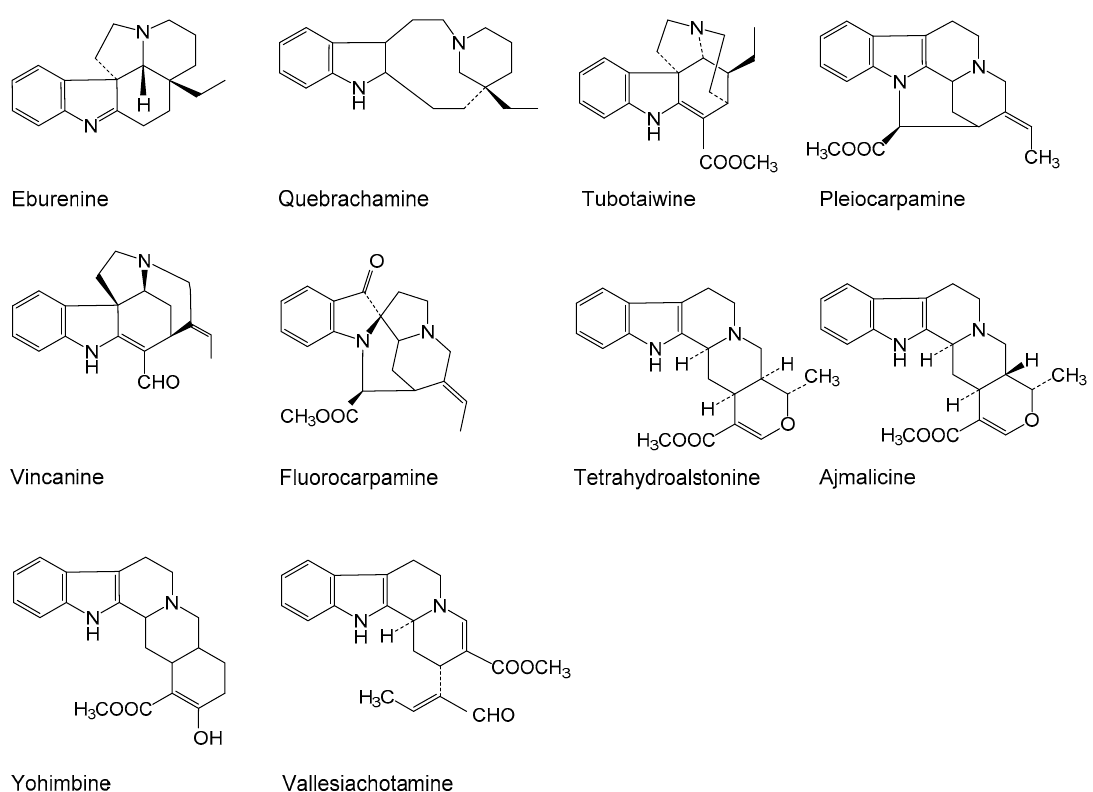
Figure 2. Structures of quantified alkaloids in the present study.